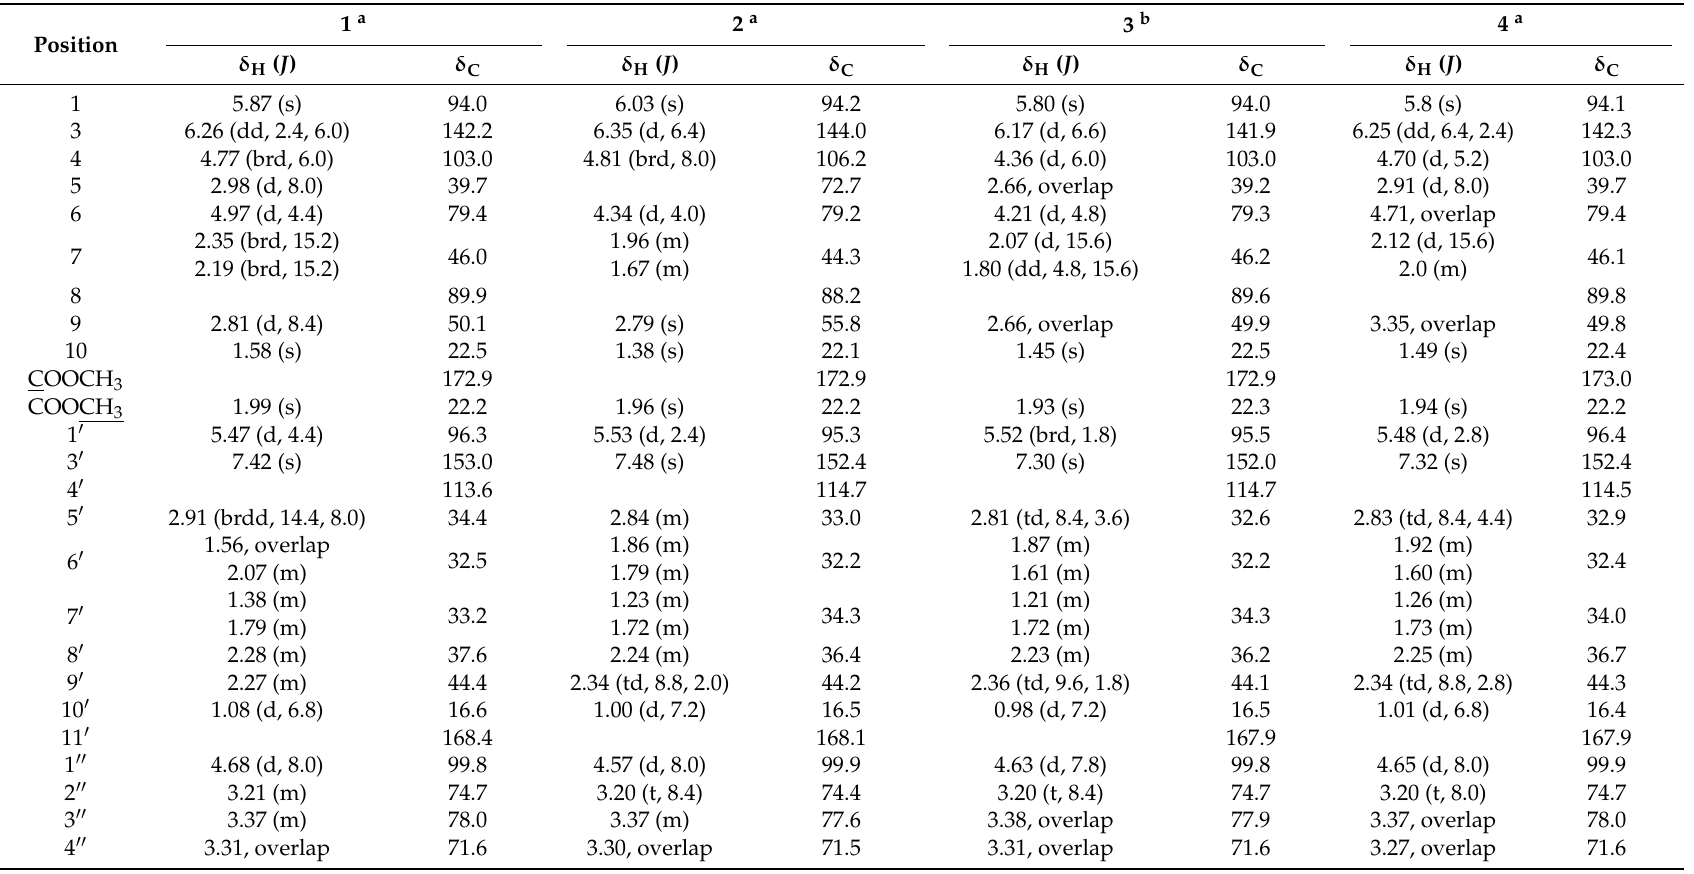
Table 1. 1 H- and 13 C-NMR data for 1 – 4